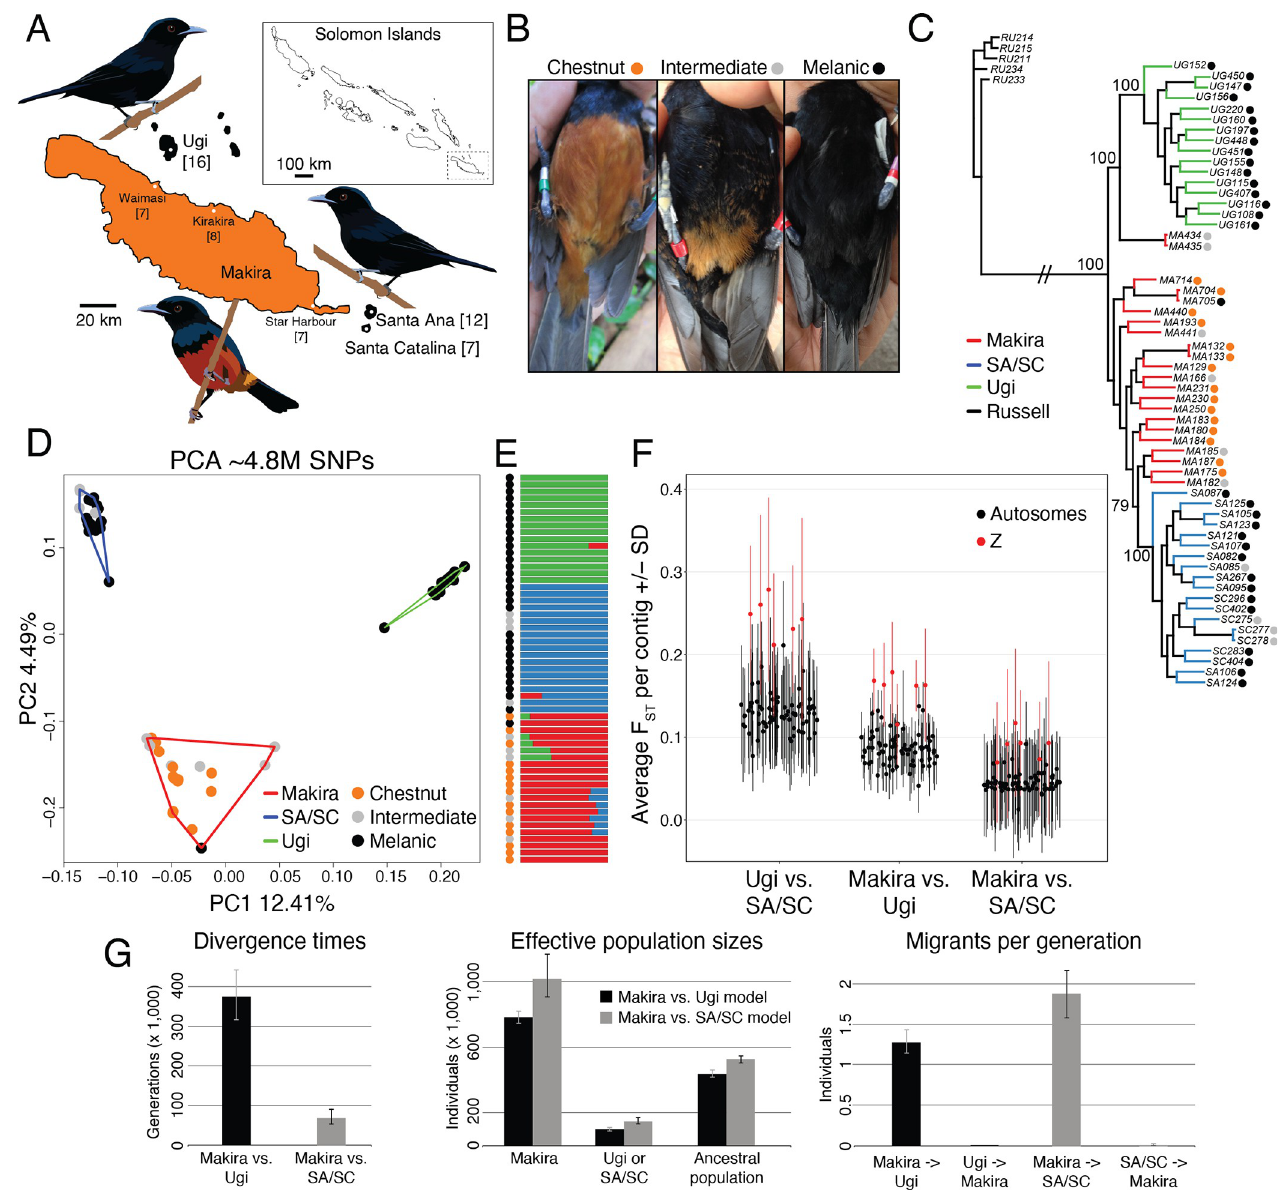
Fig 1. Genetic differentiation and demography of M . c . megarhynchus and M . c . ugiensis . A. Study area, sample sizes and predominant phenotype on each island. The map was downloaded and modified from www.diva-gis.org. B . Representative pictures of chestnut-bellied, intermediate and melanic individuals (color key used throughout the manuscript). Maximum Likelihood tree ( C ) and PCA ( D ) indicating the origin and coloration phenotype of each individual. E . Admixture plot showing the proportion of ancestry for each individual belonging to three different genetic clusters. Each cluster is color-coded by the island from which samples originated and the phenotype is shown by color-coded circles on the left of the plot. F . Pairwise F ST estimates summarized by contig. G . Demographic reconstructions indicating estimates of divergence times, effective population sizes, and migrants per generation.